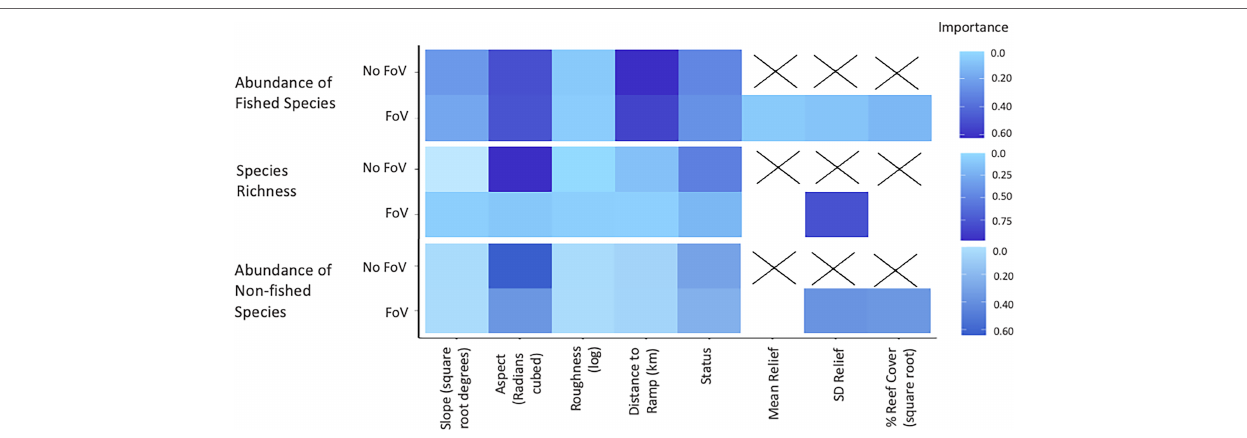
FIGURE 3 | Importance scores for each predictor across all valid models. No field of view (FoV) indicates models which only considered fine scale bathymetry and its derivatives compared to FoV where habitat characteristics classified from images of habitat at the sample sites were